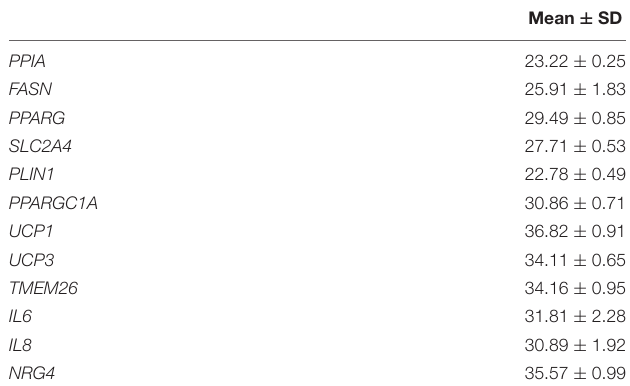
TABLE 1 | Representative Ct values of analyzed